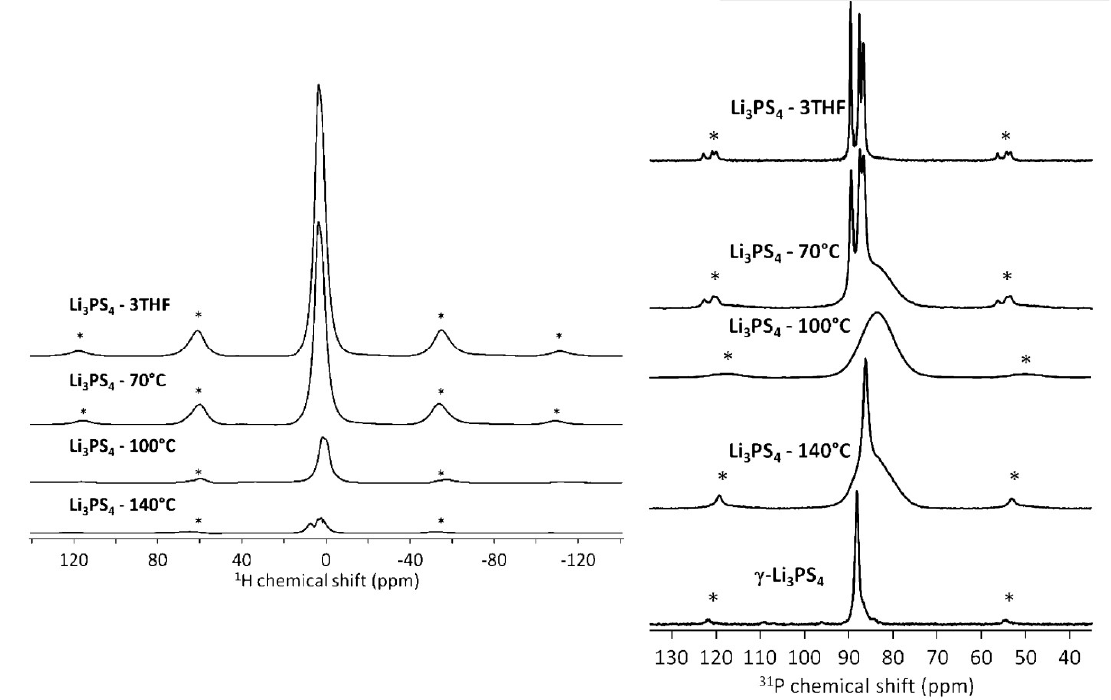
Figure 8. (Left) Proton MAS spectra of the Li 3 PS 4 glasses treated at various temperatures. (Right) 31 P MAS spectra of the same Li 3 PS 4 glasses. The asterisks indicate spinning sidebands [30] .